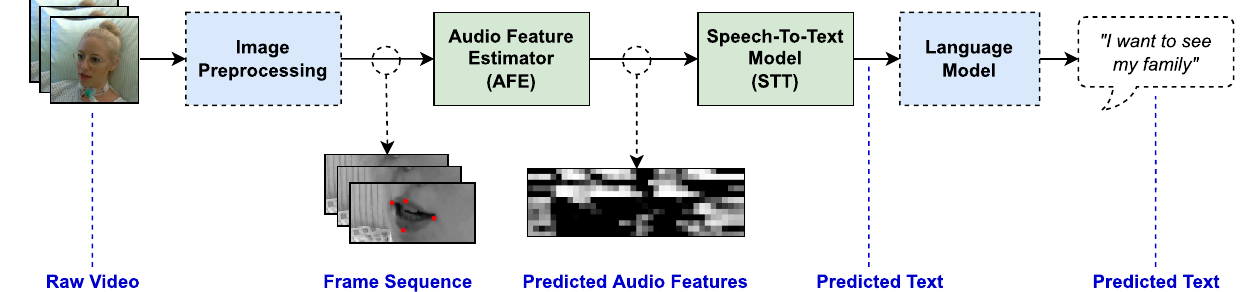
Figure 1. Full overview over the proposed system for Visual Speech Recognition. Single frames extracted from the source video pass through an image preprocessing pipeline followed by an Audio Feature Estimator (AFE) to infer the spoken audio features from the sequence of silent frames. The predictions serve as an input to a Speech-To-Text (STT) model for automatic speech recognition (ASR). Finally, the predicted, decoded sentences are corrected by a language